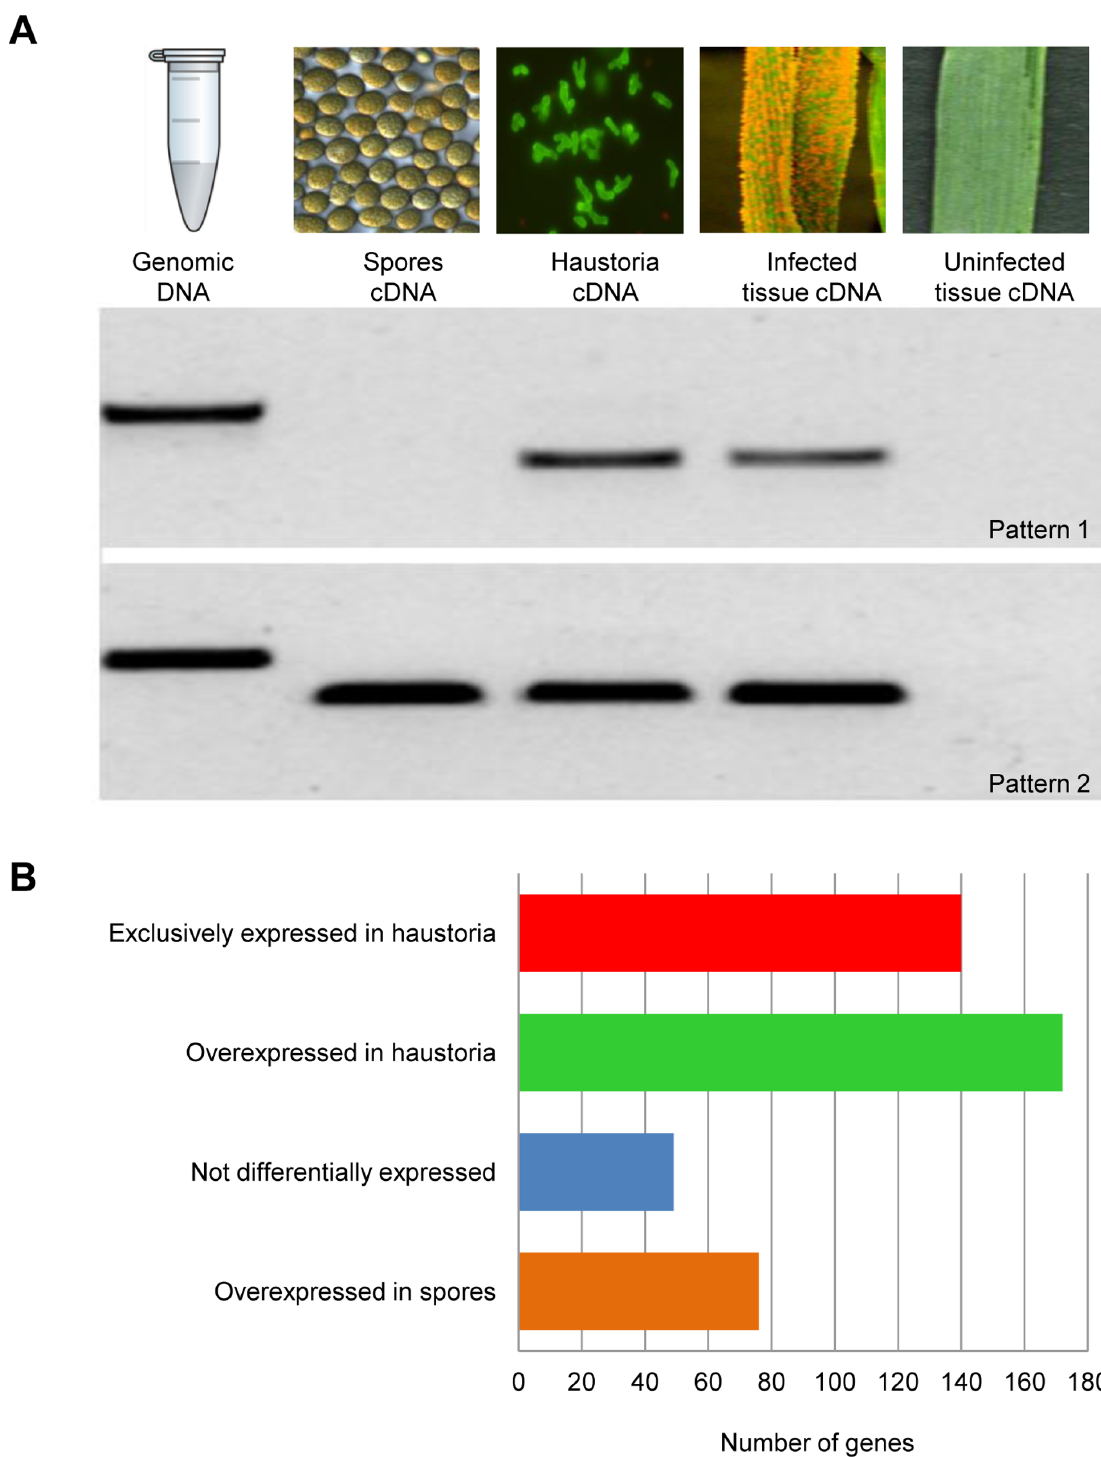
Figure 1. Effector expression patterns. A. Ninety four HSPs were selected arbitrarily and their expression patterns were analysed by RT-PCR. Primers were designed to amplify the full length gene sequence minus the signal peptide-encoding region. Pst 104E137A- genomic DNA, and cDNAs from germinated spores, isolated haustoria, infected wheat leaves, and uninfected wheat tissue were used as templates. Two expression patterns were obtained: 1. Expression only during the biotrophic phase (Pstv_3161-1), and 2. Expression during early and late stages of development (Pstv_7541-1). None of the tested effector candidates were amplified from uninfected wheat leaves. B. Number of HSPs showing digital expression patterns as shown. Overexpression was evaluated using Baggerley’s test [42], genes with a FDR corrected p-value less than 0.05, fold change . 2 and a difference of at least 20 were considered to be significant.